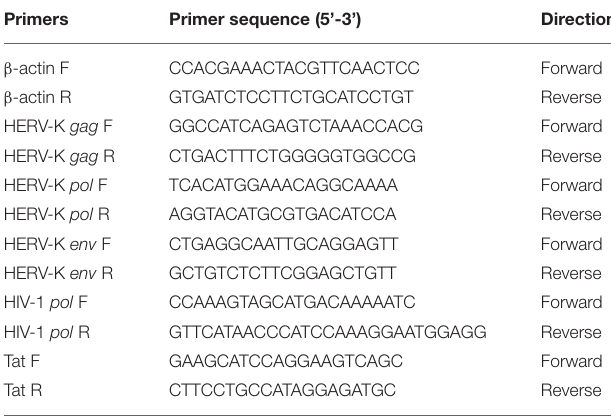
TABLE 1 | Primer sequences for real-time quantitative